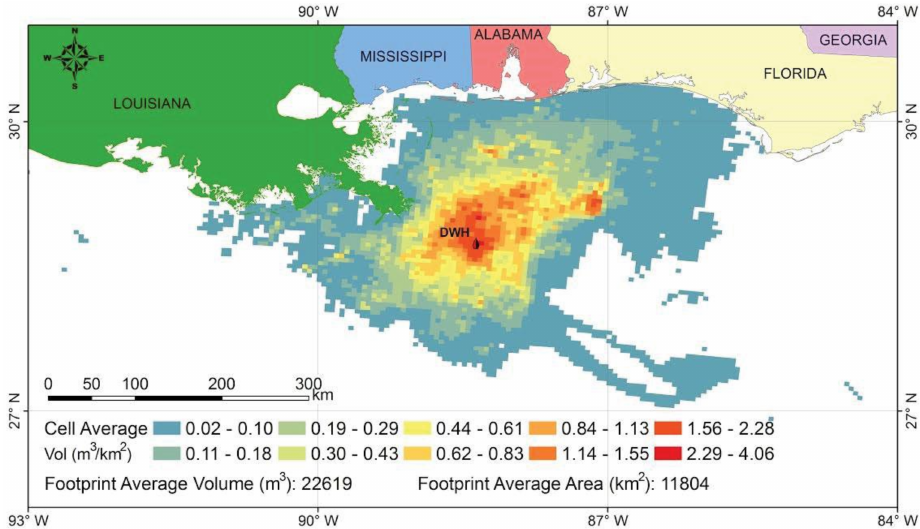
Figure 5. Map of surface oil spilled from DWH (24 April–3 August 2010) visible to SAR, showing oil distribution and average volume of surface oil (m 3 km − 2 ) gridded at 5 × 5 km scale across a cumulative footprint of 149,000 km 2 (from